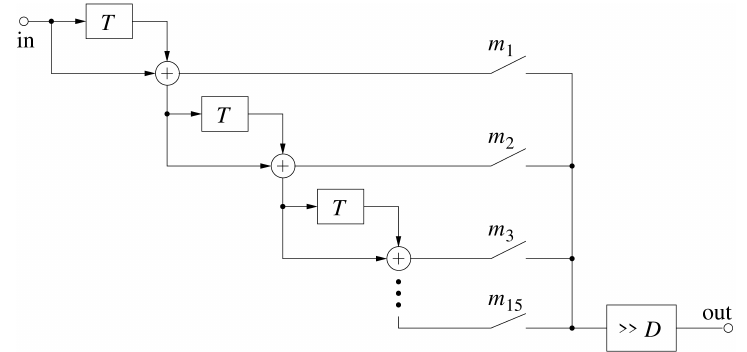
Figure 2. Structure of the programmable filter with flat frequency